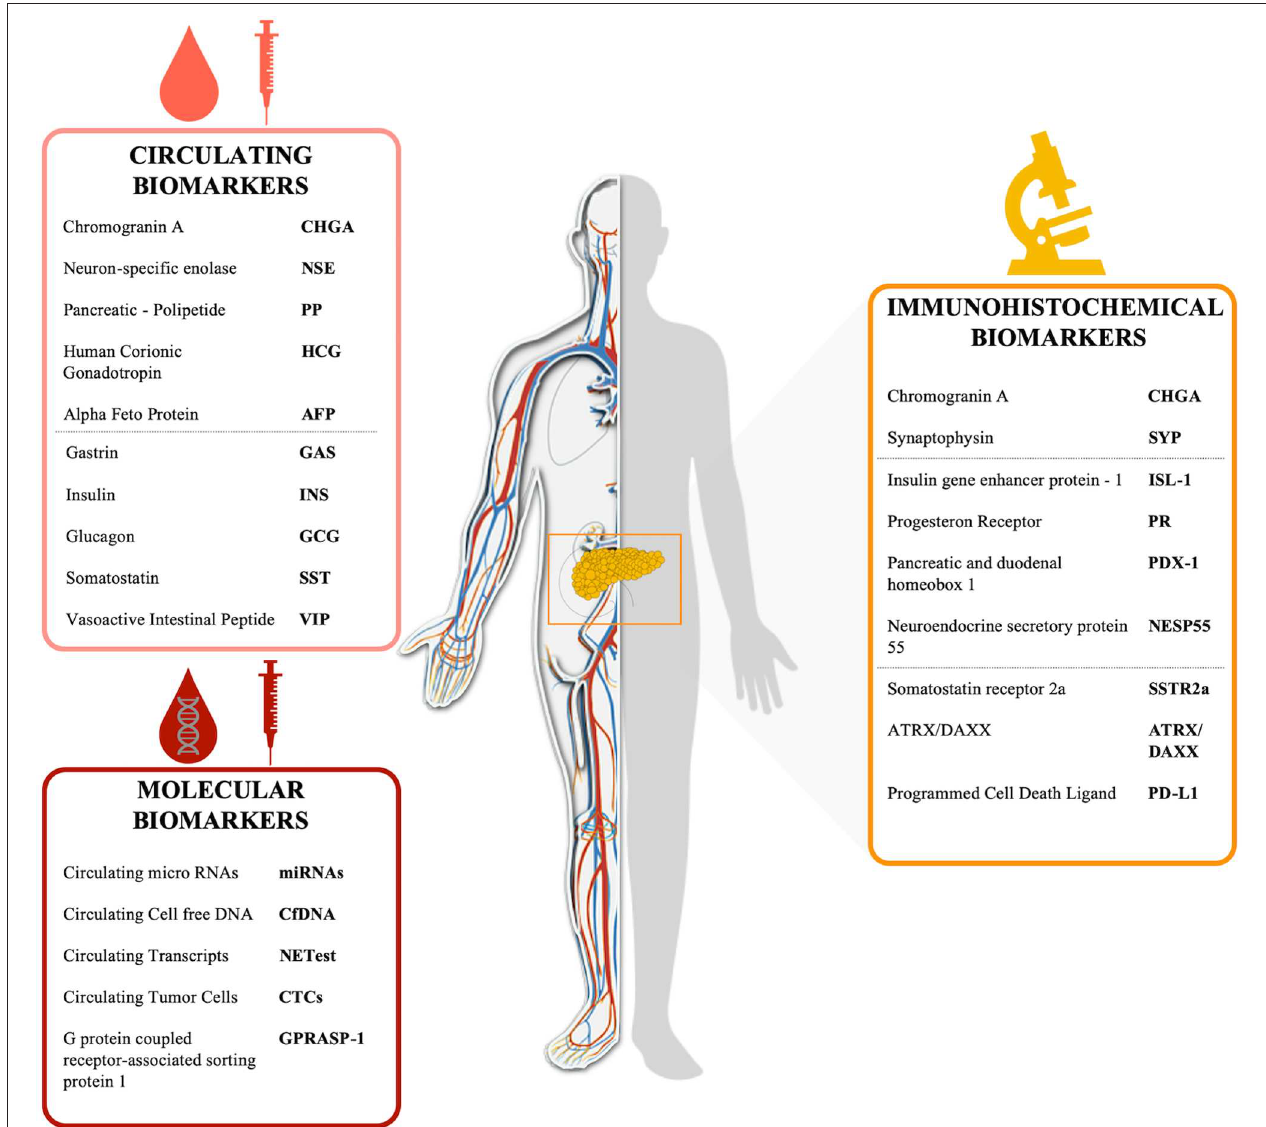
FIGURE 1 | Schematic representation of PanNEN biomarkers Circulating peptides (i.e., CHGA, PP) are circled in light red, markers assayed by IHC on tissue (i.e., CHGA, SSTR) are circled in yellow and circulating molecular biomarkers (i.e., RNA transcripts, cfDNA) are circled in